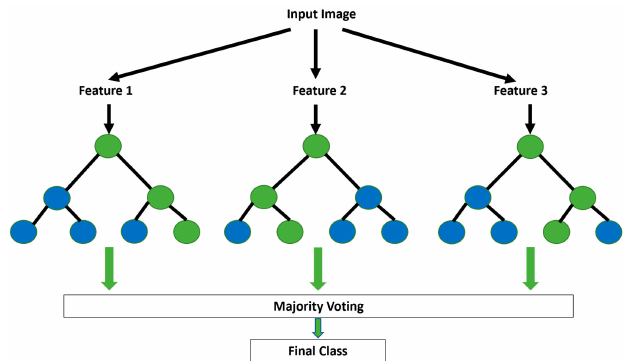
Figure 5. Random forest algorithm input and output process based on majority